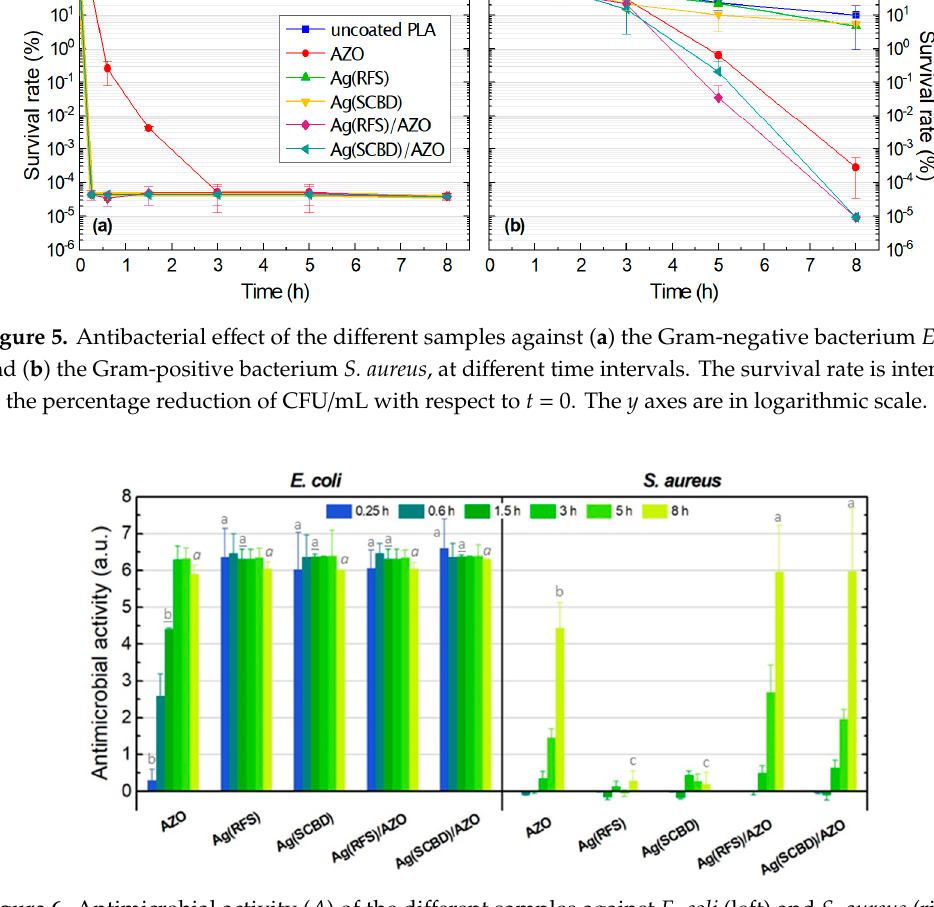
Figure 6. Antimicrobial activity ( A ) of the different samples against E. coli (left) and S. aureus (right). Statistical analysis refers at same times and, for each of them, different letters indicate significant differences among coated films ( p < 0.001). The same character (normal, italic and underscored) is used for each considered time.